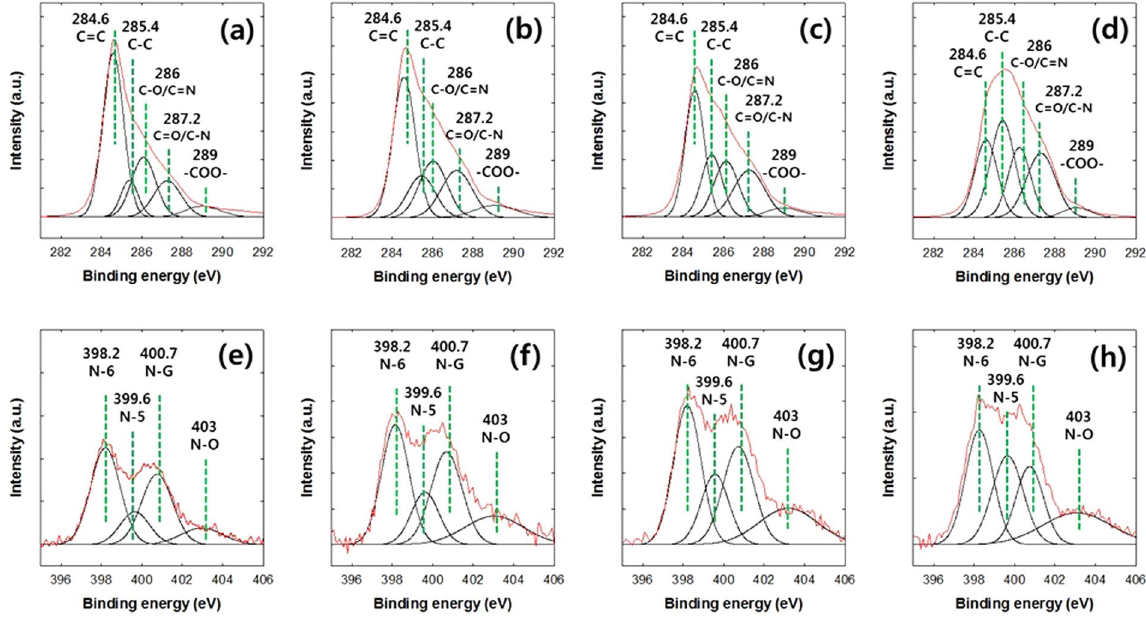
Figure 5. Curve fitting of the ( a ) C1s peak for NNO-1h, ( b ) C1s peak for NNO-3h, ( c ) C1s peak for NNO-6h, ( d ) C1s peak for NNO-24h, ( e ) N1s peak for NNO-1h, ( f ) N1s peak for NNO-3h, ( g ) N1s peak for NNO-6h, and ( h ) N1s peak for NNO-24